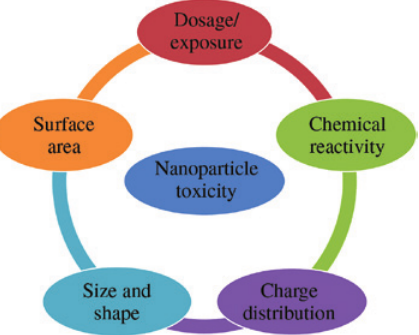
Figure 1: Different factors that may affect the overall toxicity of a